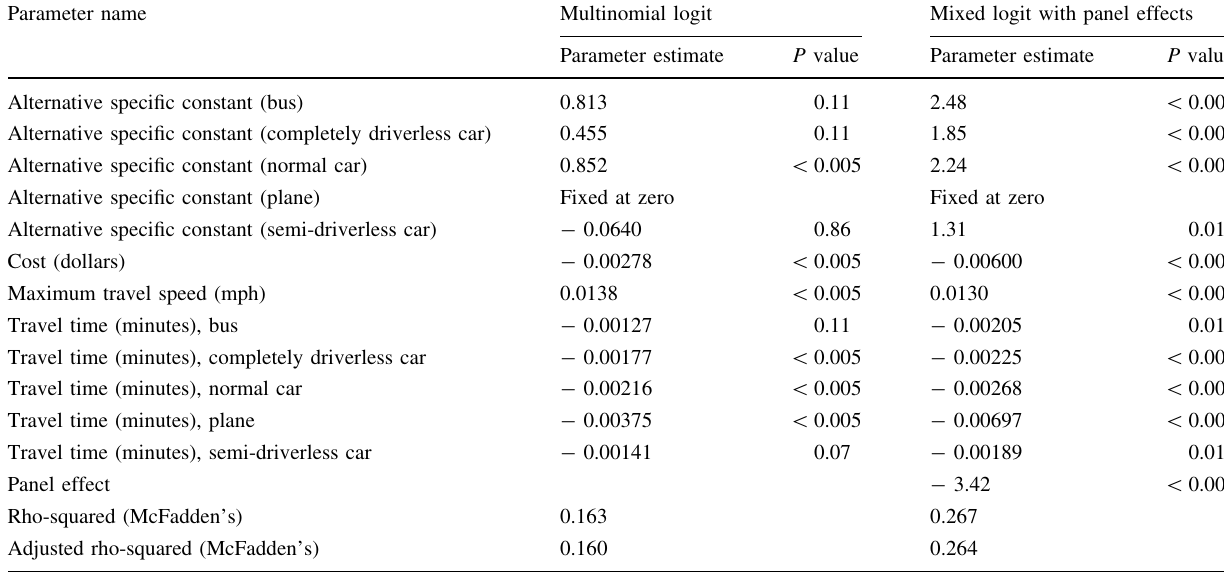
Table 5 Results from mode choice model